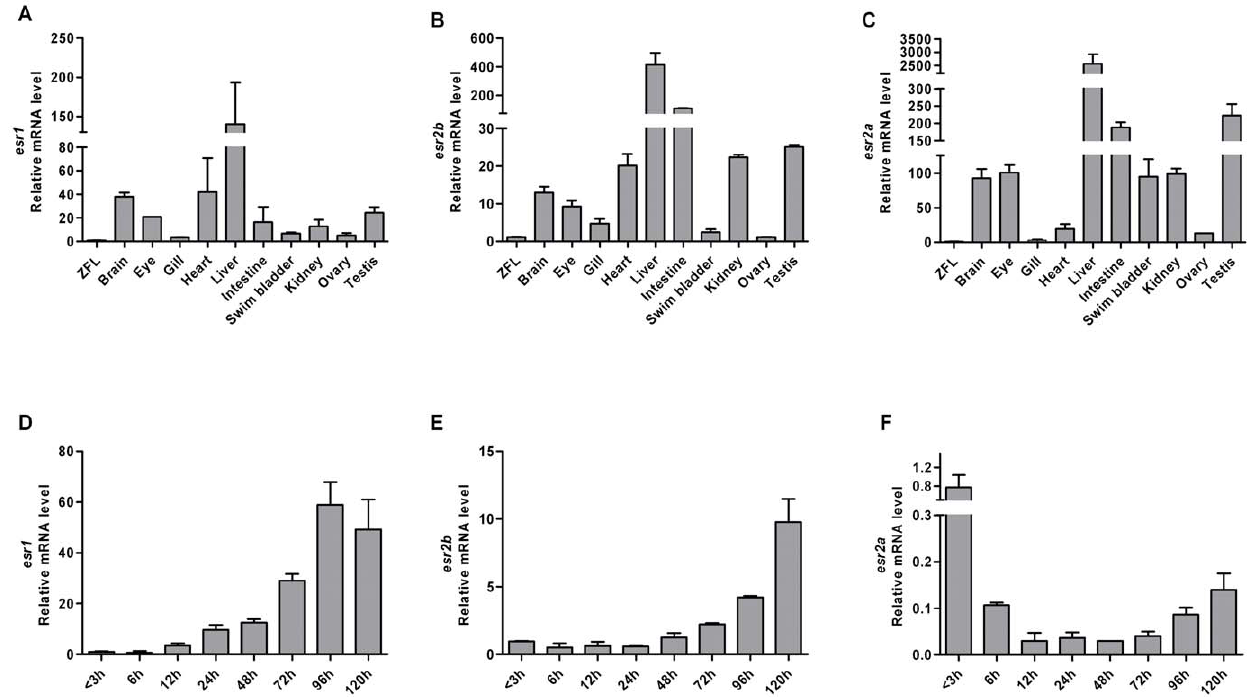
Figure 1. Expression levels of zebrafish estrogen receptors in organs, in embryos and in early larvae. The expression levels of esr genes are shown. (A) esr1 expression in organs; (B) esr2b expression in organs; (C) esr2a expression in organs; (D) esr1 expression in embryos and early larvae; (E) esr2b expression in embryos and early larvae; (F) esr2a expression in embryos and early larvae. Data are represented as mean 6 SD of three independent